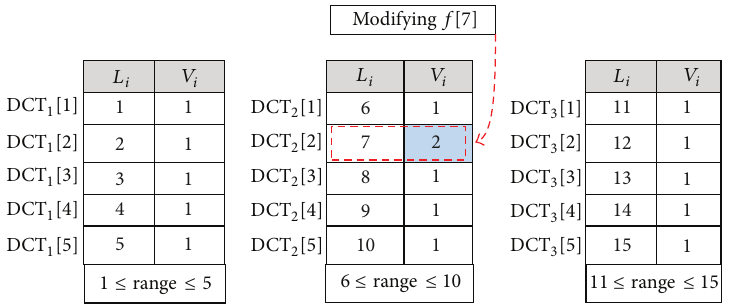
Figure 2: Performing modify operation on 𝑓[7] when the number of blocks in each table is 5.